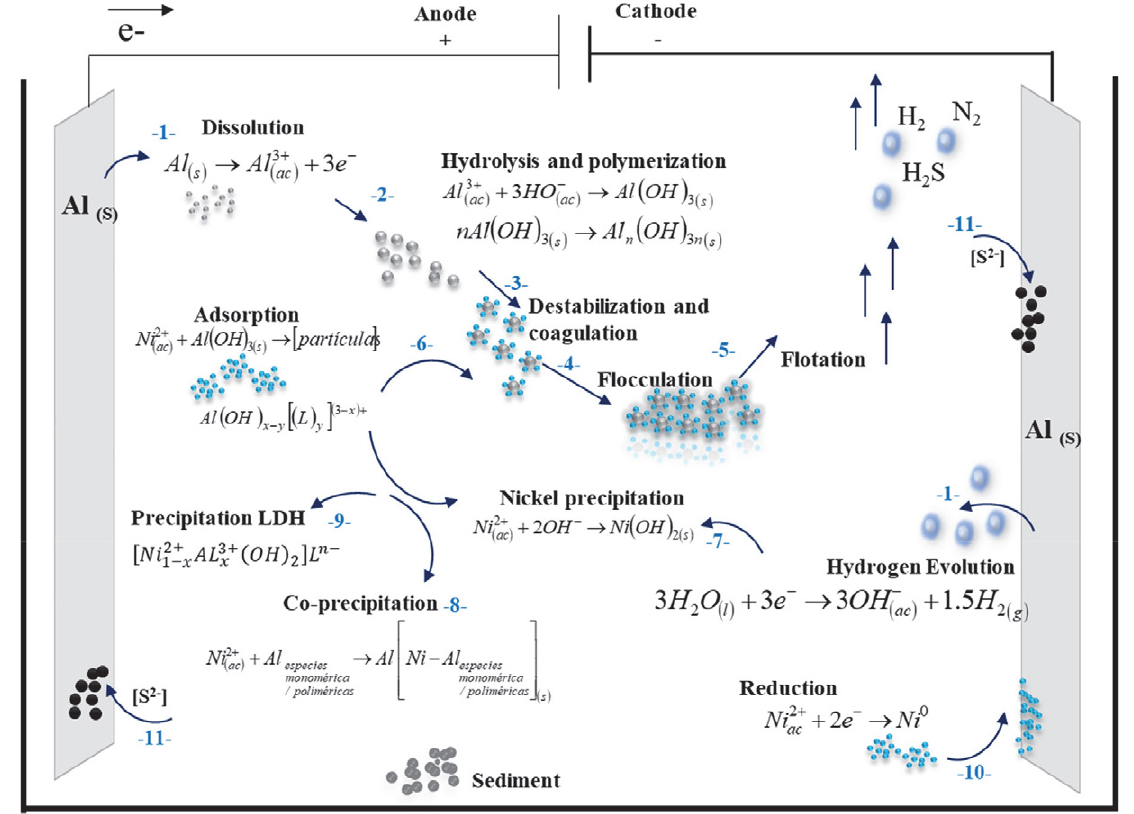
Figure 6. Schematic representation of the nickel removal mechanism by electrocoagulation of the Ni(II)-NH 3 -CO 2 -SO 2 -H 2 O